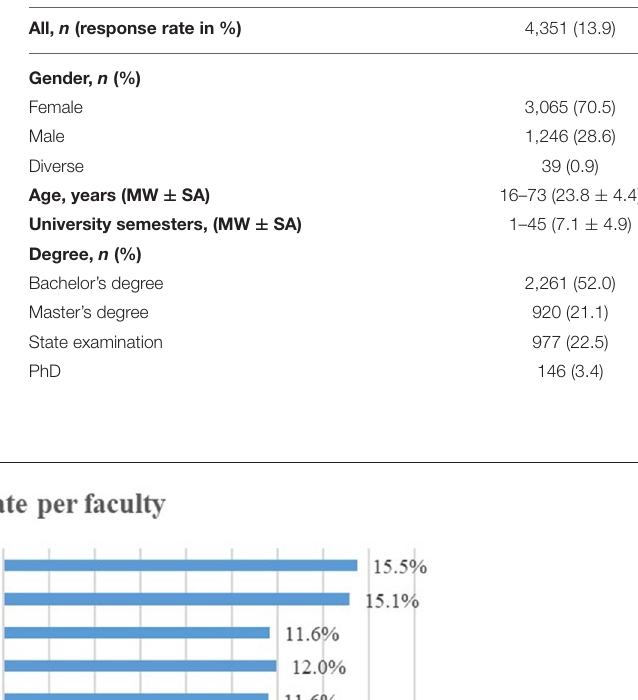
TABLE 1 | Participant characteristics.